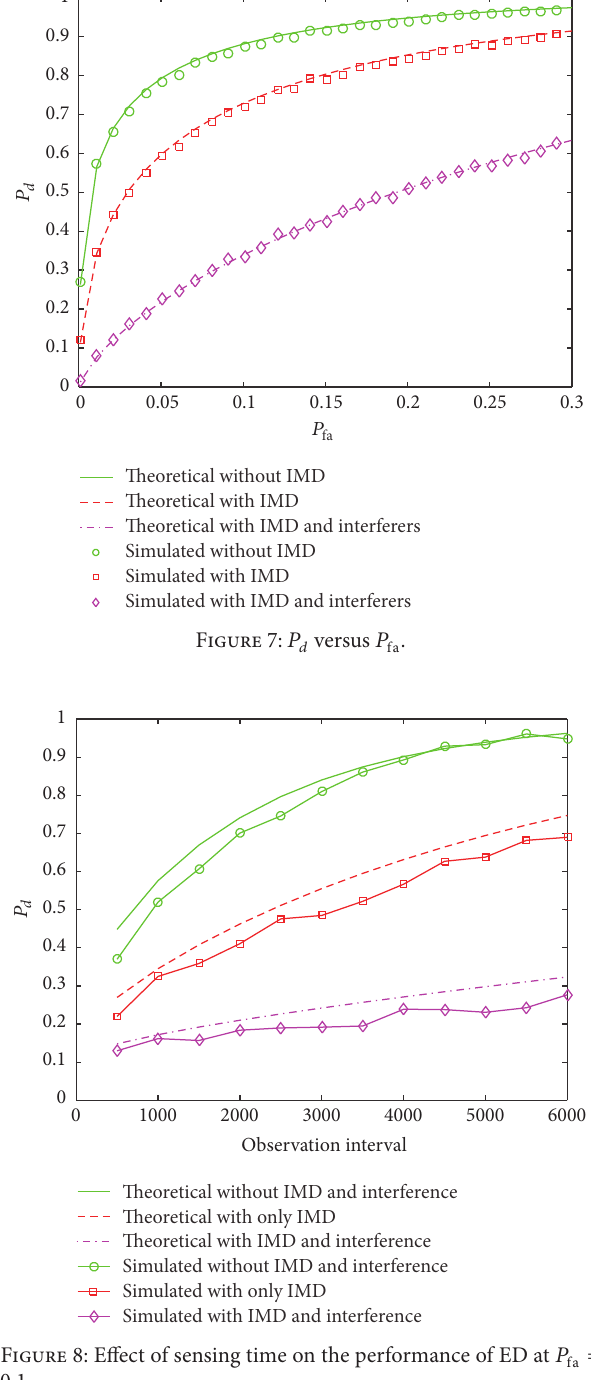
SIMD = −14.86 dB, 𝑃 fa = 0.1 , and PU at 600 m. In order